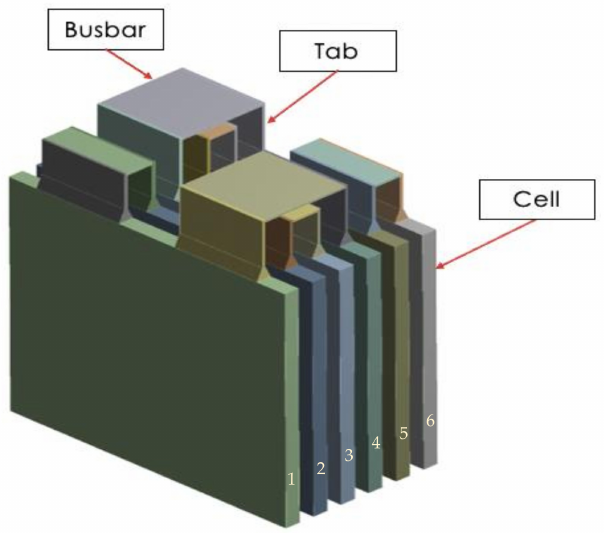
Figure 1. Schematic of the 3S2P LIB module, showing the six cells identified according to their position within the fluid domain, inlet (number 1) and outlet (number 6) cells.